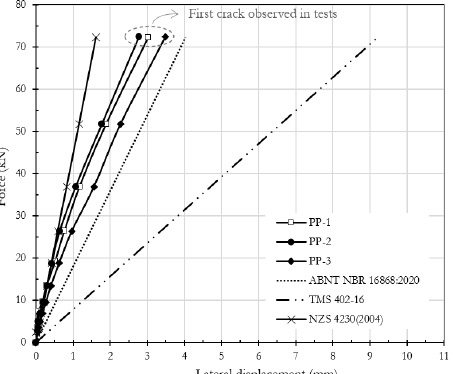
Figure 6. Load-displacement diagrams obtained from technical codes in comparison to experimental results. Source: The